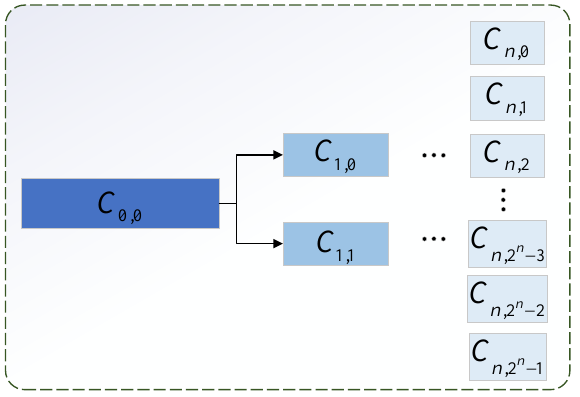
Figure 4. A brief illustration of WPD. DMT: The raw data are reshaped from a one-dimensional time sequence signal to a two-dimensional signal without signal processing. A simple illustration of DMT is shown in Figure 5, numbers 0 to 1023 denote time sequence signal data point, and each blue square represents the value of the matrix. Supposing that the length of a signal sample is 1024, through DMT, the output data are made into a 32 × 32 matrix.